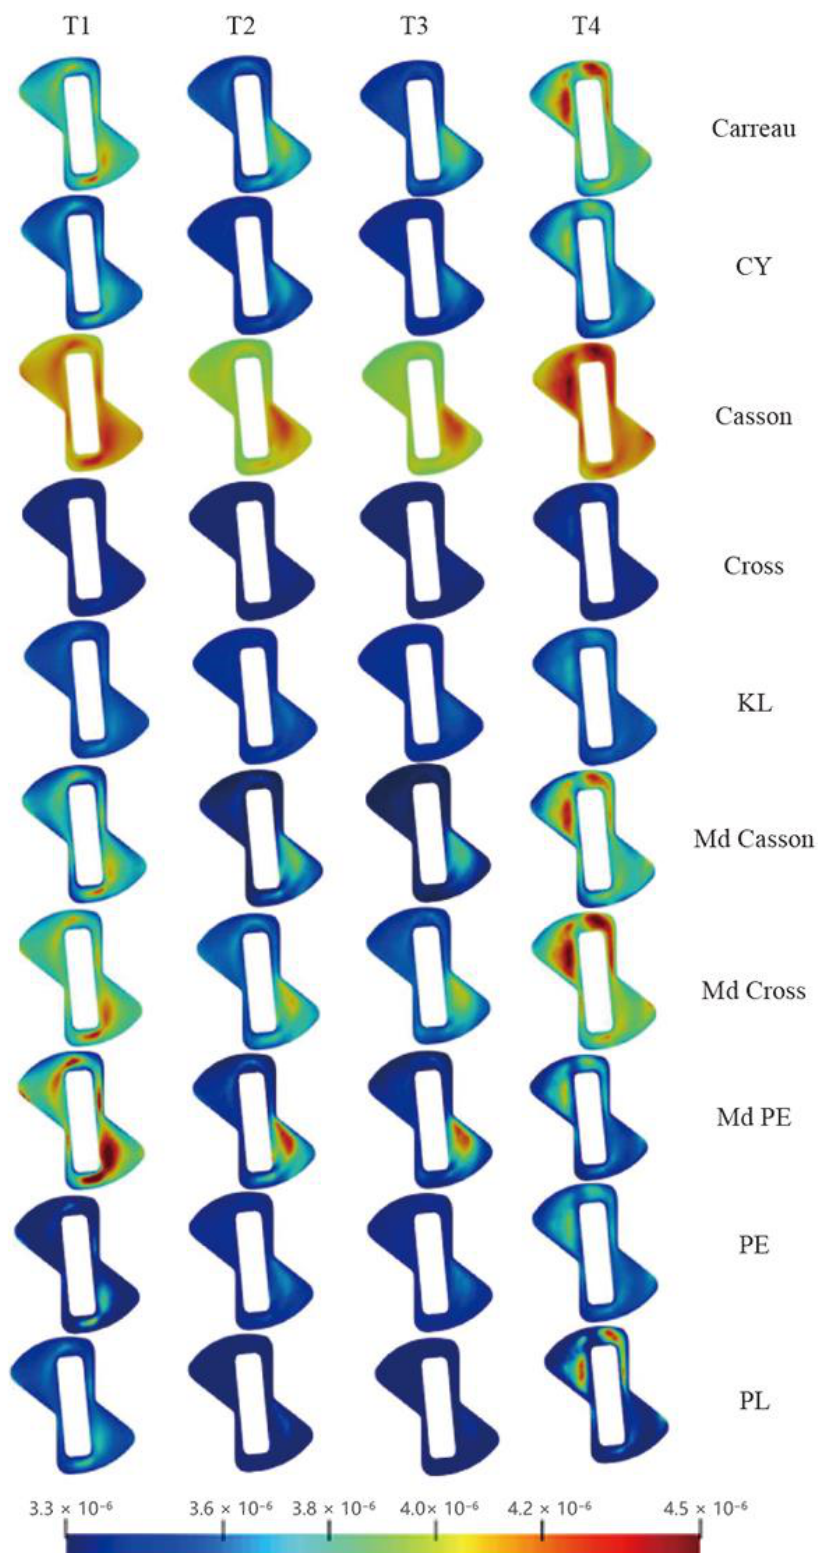
Figure 16. Viscosity contours of the hinge region for different non-Newtonian models.